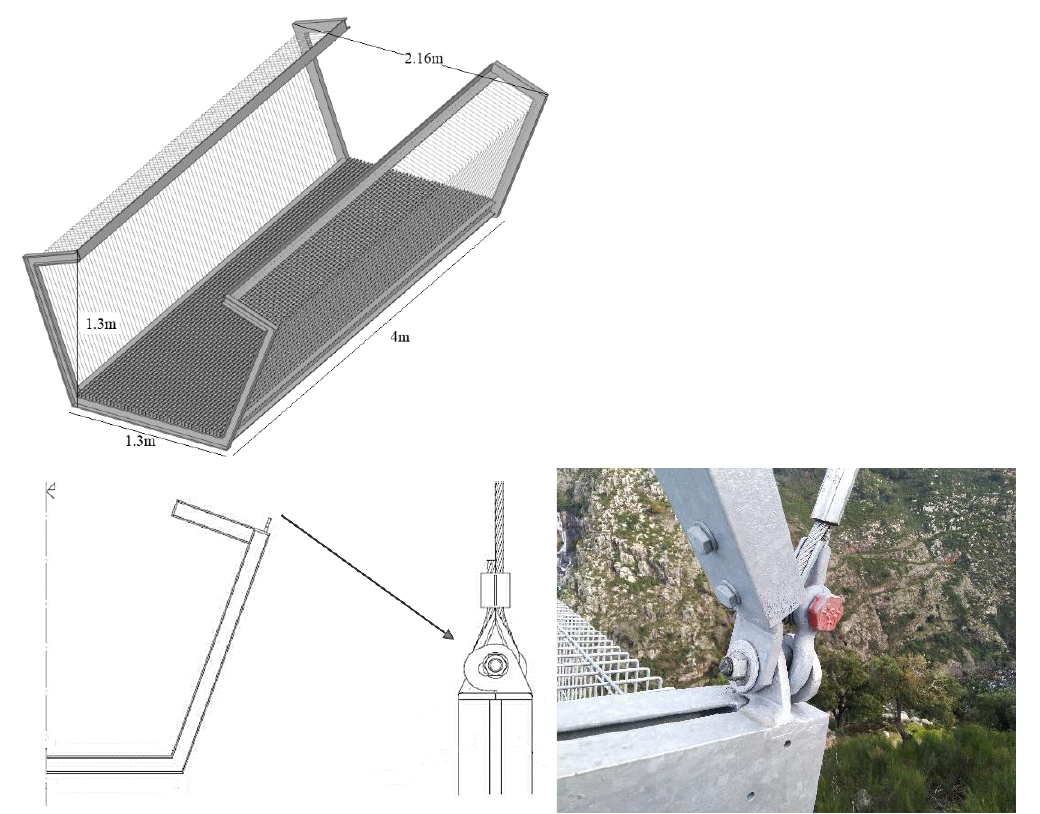
Figure 3. Geometry of one module of the bridge and the connection point to the hangers [13].